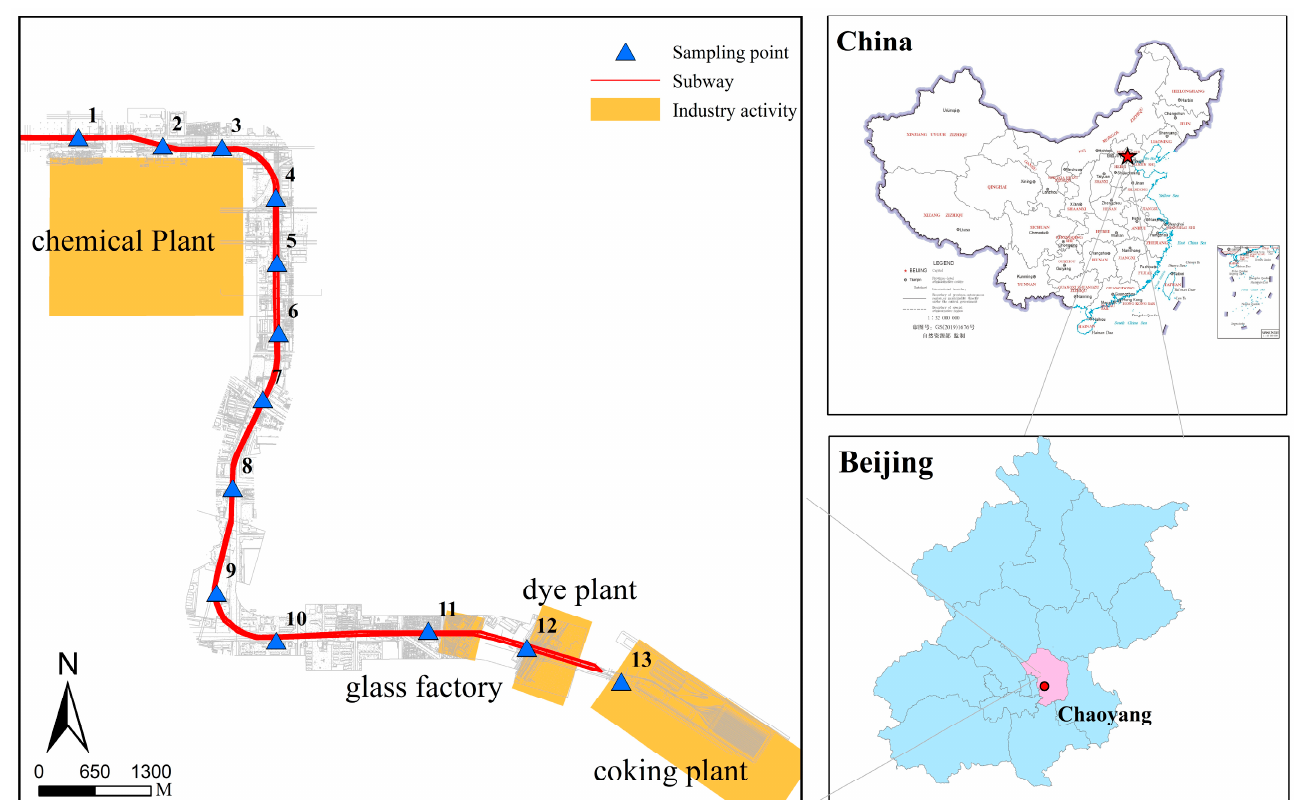
Figure 1. The location of the study area and distribution of 13 sampling points.